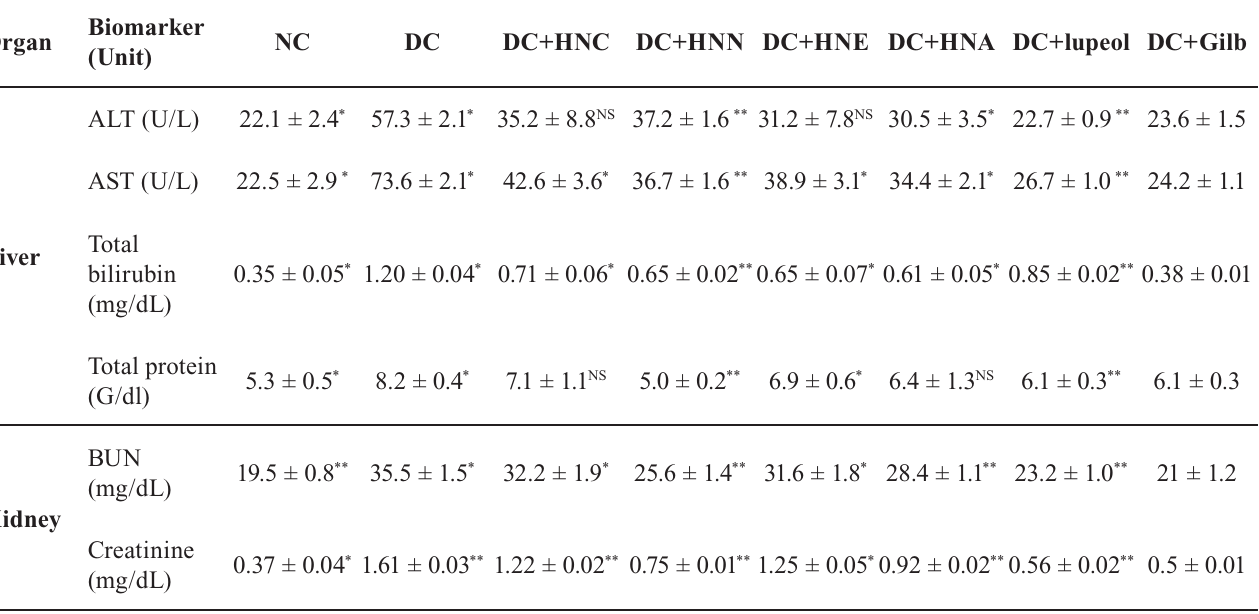
TABLE II - Effects of H. nepalensis extracts and lupeol on liver, kidney and heart biomarkers in alloxan induced diabetic rats